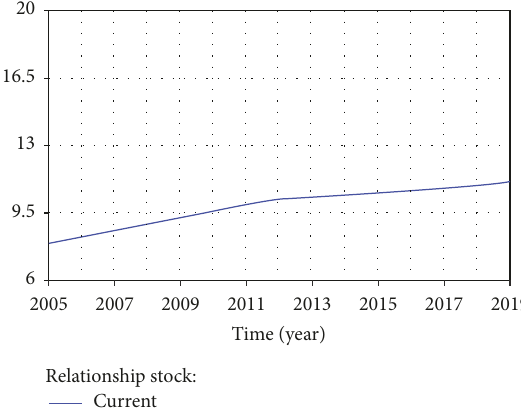
Figure 7: Relationship stock (RS)